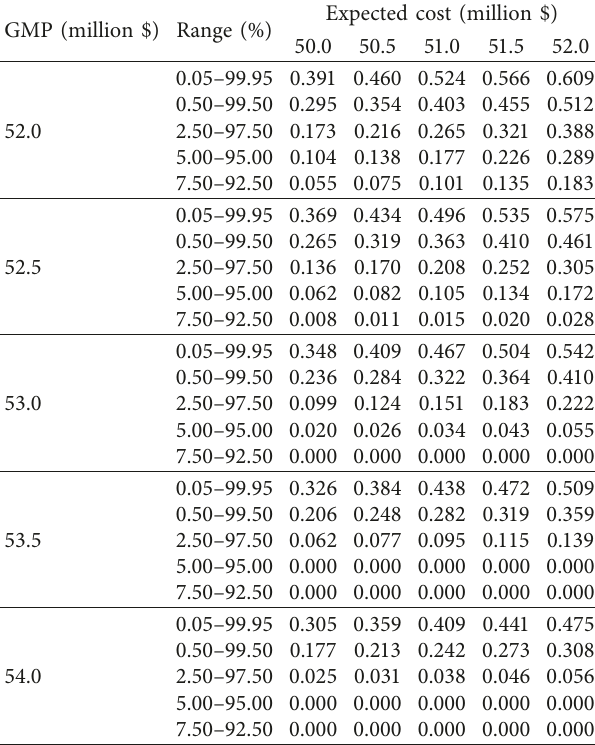
Table 7: Fluctuation of K -ratio under various conditions.